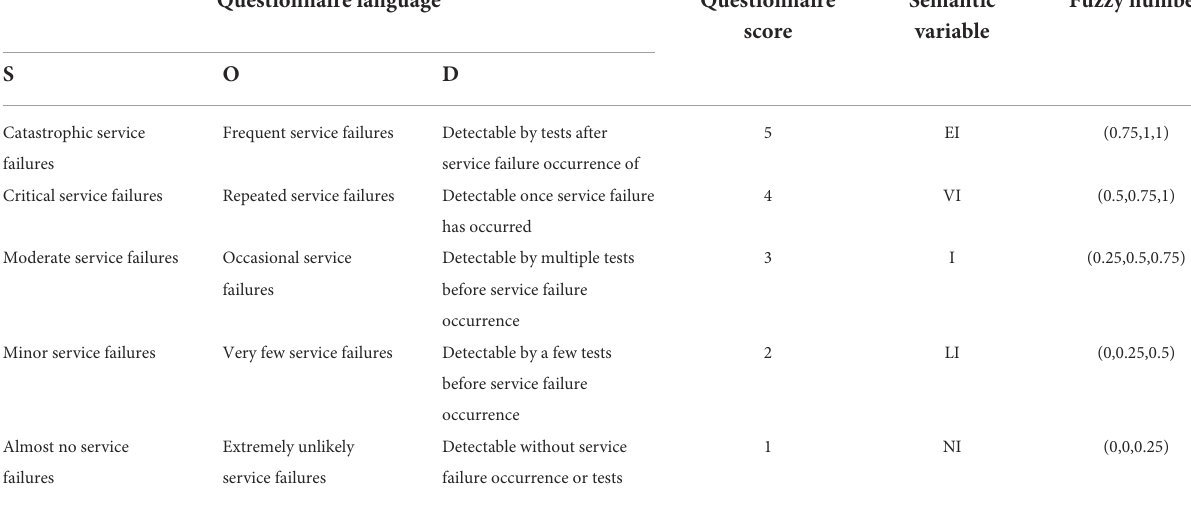
TABLE 1 Correspondence table between questionnaire data and fuzzy numbers [adopted from Bhuvanesh Kumar and Parameshwaran (27)]. Questionnaire